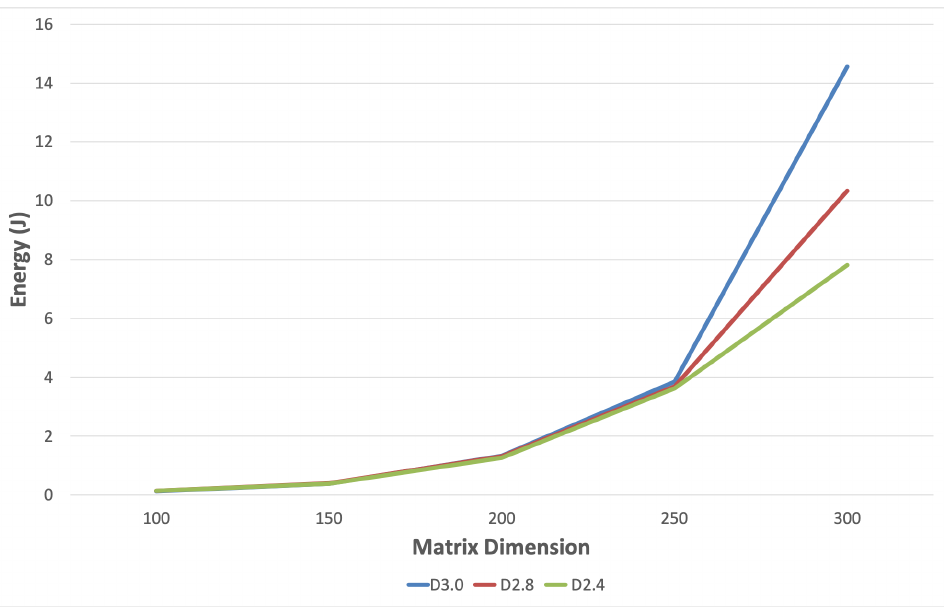
Figure 4. Total energy consumption in joule (J) for small matrix dimensions, where computation is estimated to be within L1